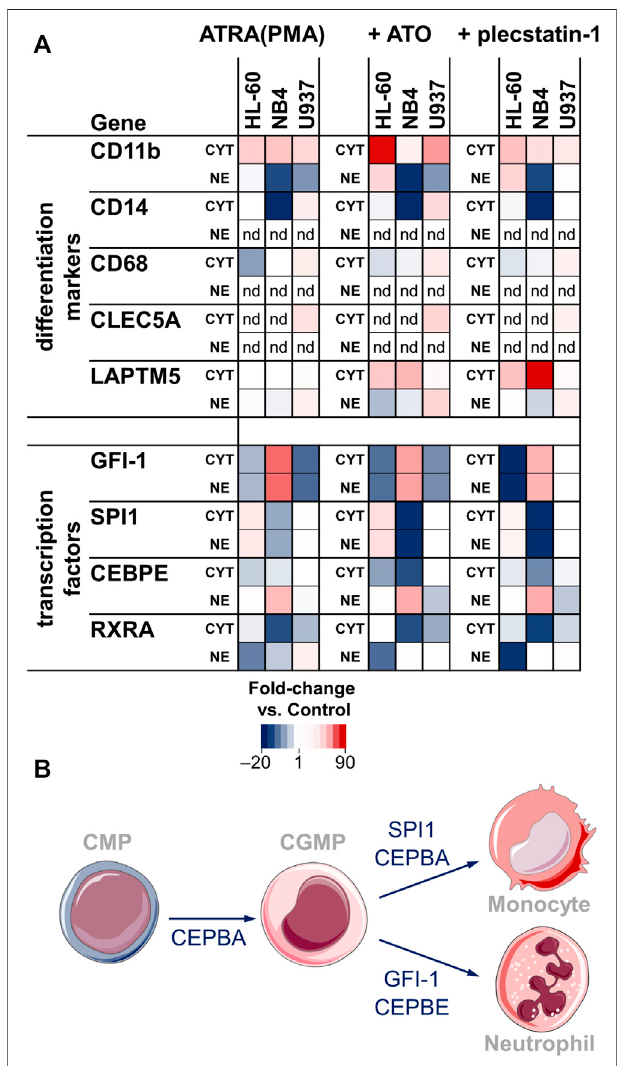
FIGURE 3 | (A) Heat map showing the fold-changes of surface marker and transcription factor abundance upon treatment with ATRA (PMA) only ( left ), ATO + ATRA (PMA) ( middle ) and plecstatin-1+ATRA (PMA) ( right ) with respect to controls. Treatments were performed over 48 h. The LFQ intensity of averaged biological replicates was used to create the heat maps. Fold-changes are given as de-logarithmised ratios with respect to untreated controls. CYT (cid:1) cytoplasmic fraction, NE (cid:1) nuclear extract fraction, nd (cid:1) not detected. (B) Simpli fi ed differentiation cascade of the common myeloid progenitor (CMP) into monocytes and neutrophils through the common granulocyte monocyte progenitor (CGMP). The involved transcription factors are given next to the